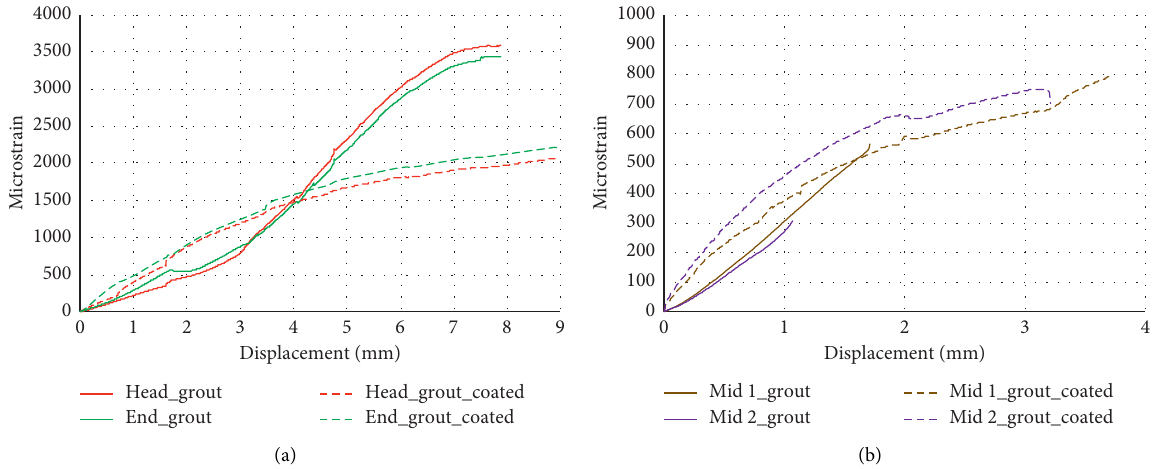
Figure 22: Strain vs. displacement for coated and uncoated GFRP rock bolt sensors fixed with grout at (a) head and endpoints and (b) midpoints.